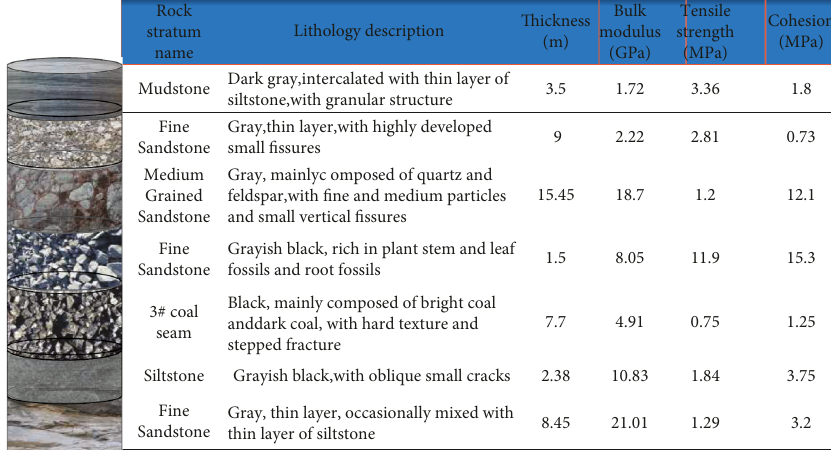
Mudstone Dark gray,intercalated with thin layer of siltstone,with granular structure